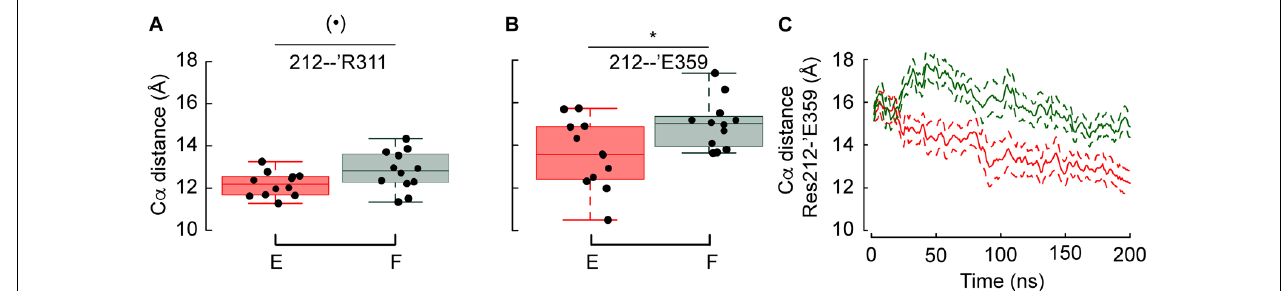
FIGURE 5 | Phe at position 212 prevents the lower thumb to approach the palm domain. (A,B) Average distances between the C α atoms of Res. 212 – ’Arg311 and Res. 212 – ’Glu359 in G212F and G212E. (C) Averaged time series of the distances between the C α atoms of G212E and G212F, respectively, and ‘Glu359. Figure color code: Glu212 red, Phe212: green. The box plots display the median, the 25–75% range (box) and estimated minima and maxima. The results of statistical analyses are presented as follows: ( · ): marginally significant, p < 0.1; * p < 0.05.